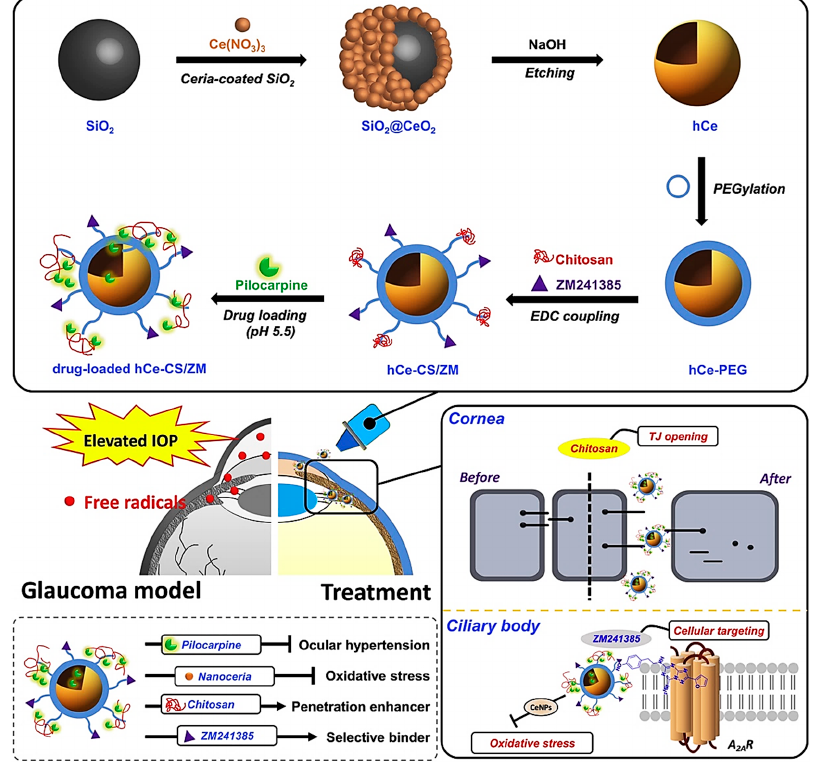
Figure 7. Schematic representation of the formulated nano-eye drops and their application for treating glaucoma. The silica templating method was used to synthesize hollow ceria nanoparticles (hCe NPs) and functionalize the samples with chitosan and ZM241385, which then were loaded with pilocarpine for the potential use as nano-eye drops (drug-loaded hCe-CS / ZM). Reproduced from